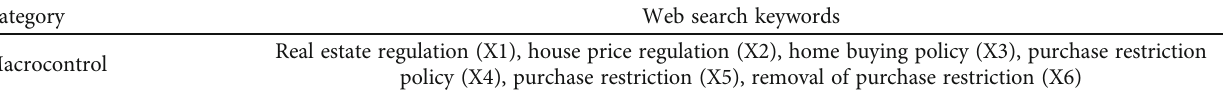
Table 1: Web search keyword phrase database.